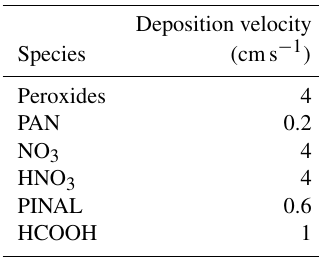
Table 2. Deposition velocities of some important species consid- ered in the model